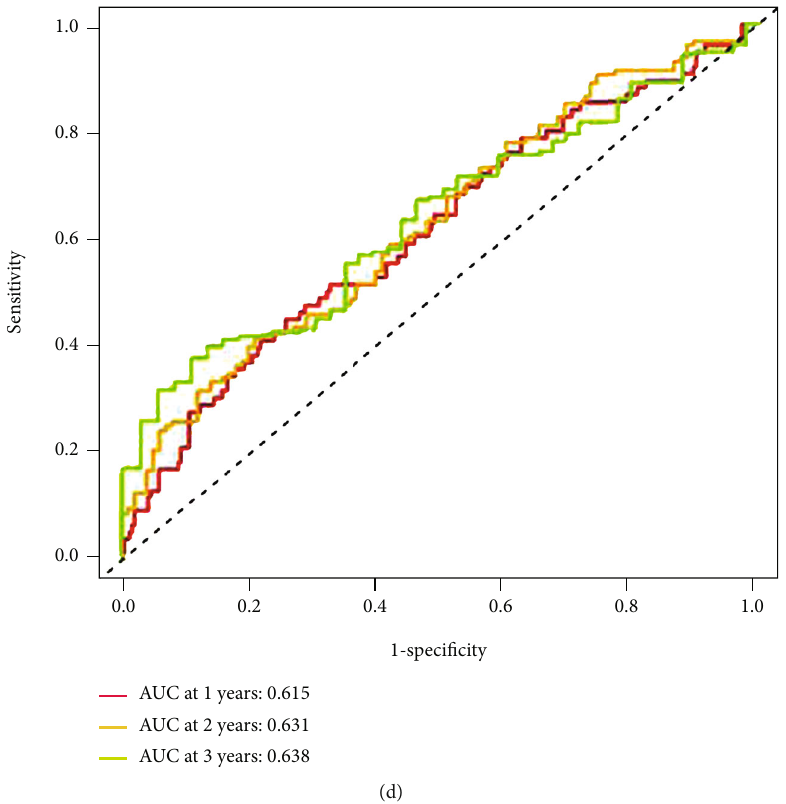
Figure 4: Univariate and multivariate COX analyses and prognostic characteristics of ferroptosis-related lncRNAs. (a) Univariate Cox analysis of ferroptosis-related lncRNA expression, (b) multivariate Cox analysis of ferroptosis-related lncRNA expression, (c) AUC value of lncRNA risk characteristics, and (d) AUC value of lncRNA risk characteristics were used to predict the 1-, 3-, and 5-year survival rates of